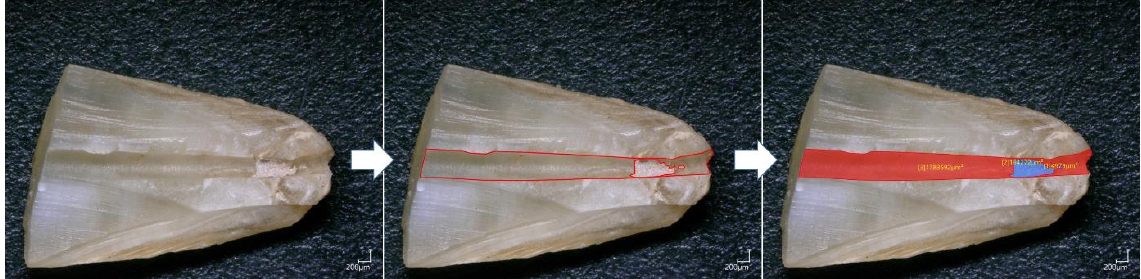
Figure 2. Methodology of residual materials area measurements using VHX-5000 software.